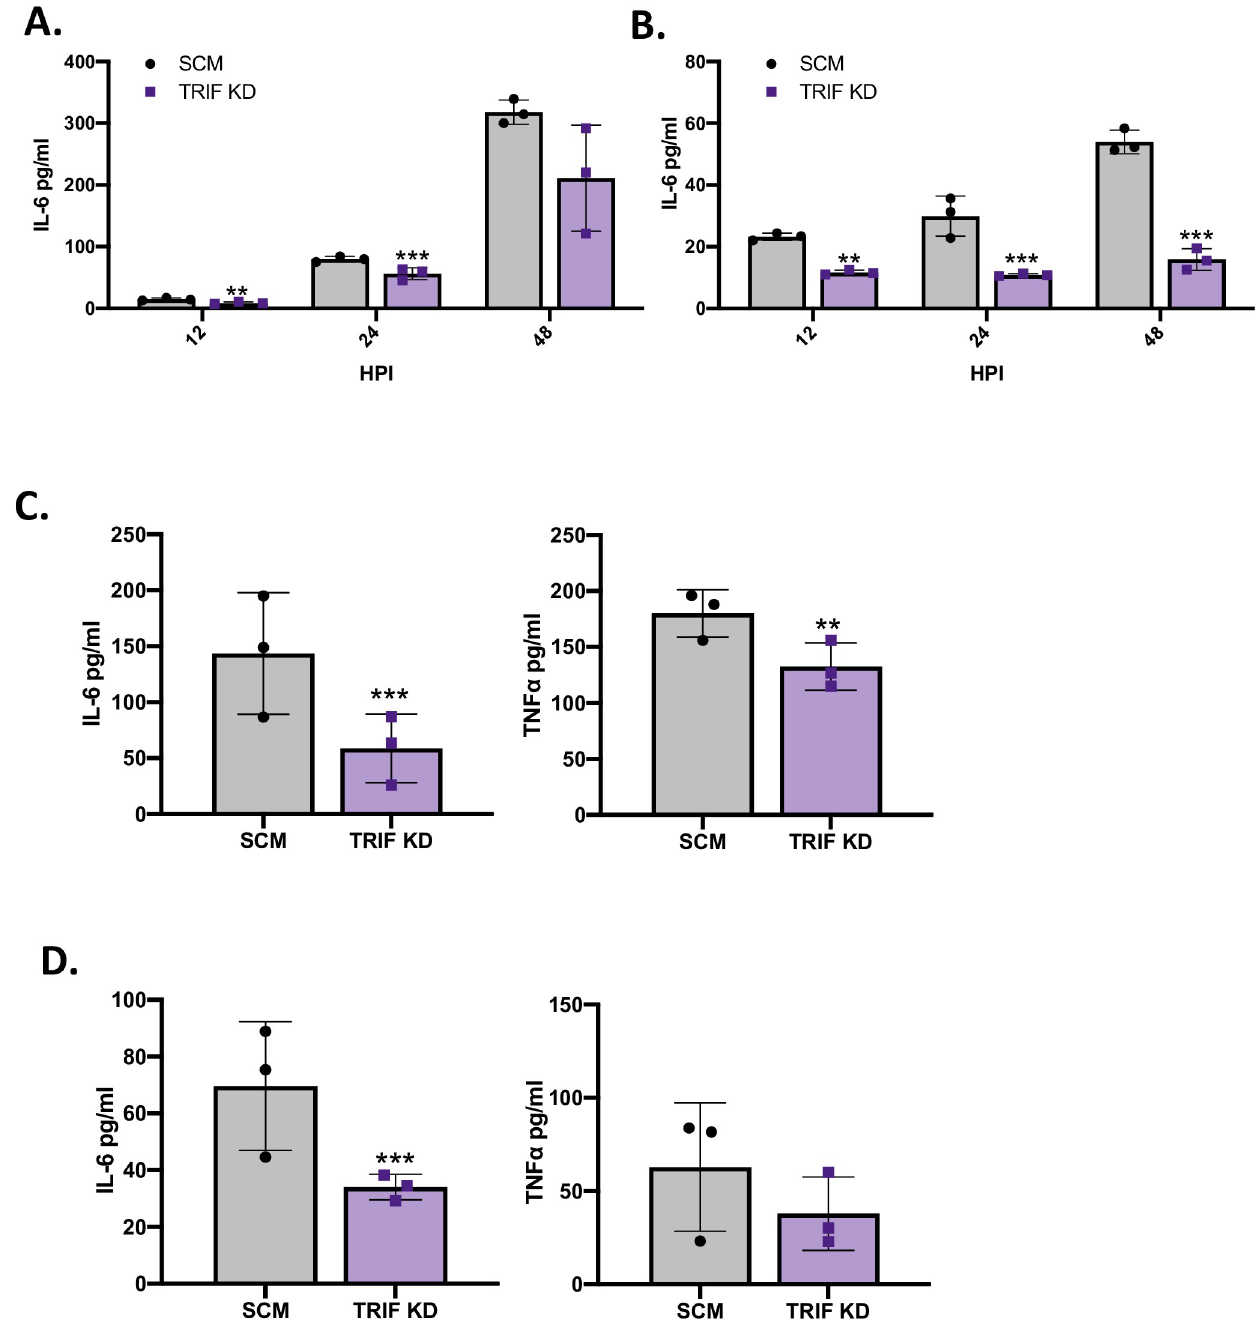
Fig 1. Effect of TRIF KD on cytokine production from human macrophages after infection with L . pneumophila . (A—B) U937 cell macrophages containing either an shRNA targeting TRIF (TRIF KD) or a non-targeting scramble shRNA (SCM) were infected with strain 130b (A) or Philadelphia-1 (B) at a multiplicity of infection (MOI) of 0.5, and the levels of IL-6 in culture supernatants at 12, 24, and 48 h post infection (HPI) were then determined by single-cytokine ELISA. (C) SCM and TRIF KD cells were infected with strain 130b at a MOI of 20, and the levels of IL-6 (left) and TNF α (right) in culture supernatants after 9 h of infection were ascertained by single-cytokine ELISA. (D) PBMC-derived macrophages containing either an siRNA targeting TRIF (TRIF KD) or a non-targeting scramble siRNA (SCM) were infected with strain 130b at a MOI of 20 for 9 h, and then the levels of secreted IL-6 (left) and TNF α (right) determined by ELISA. The graphs in (A–D) show the average cytokine levels pooled from three (A -C) or two (D) independent experiments, each done in technical triplicate, with standard errors. The cytokine levels (pg/ml) were calculated relative to serial dilution of recombinant cytokine controls. Asterisks indicate points at which the values for samples from KD cells were significantly different from those for samples from SCM cells ( �� P < 0.01, ��� P < 0.001, by Student’s t test).